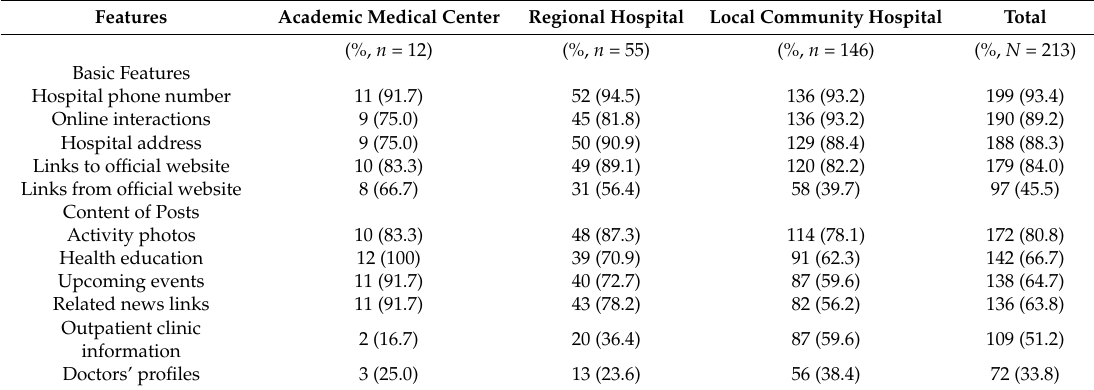
Table 4. Features of official Facebook fan pages of 213 hospitals in Taiwan.